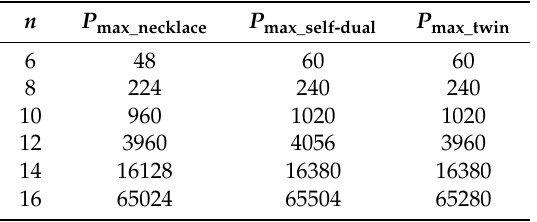
Table 2. The upper bounds of period for necklace, self-dual necklace and twin-necklace ordering STGCs from length 6 to length 16. n P max_necklace P